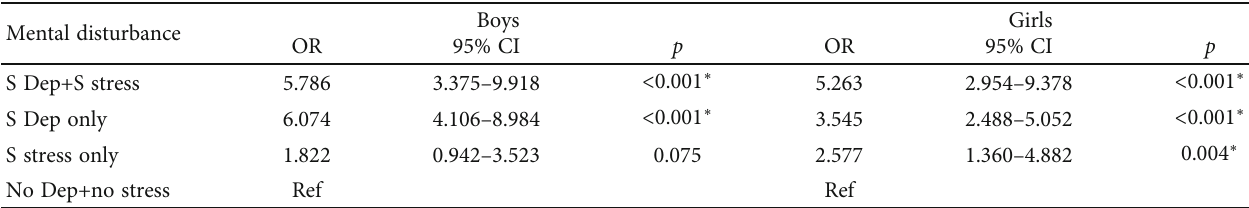
Table 4: Multivariate logistic regression with poor sleep (below median total sleep score) as